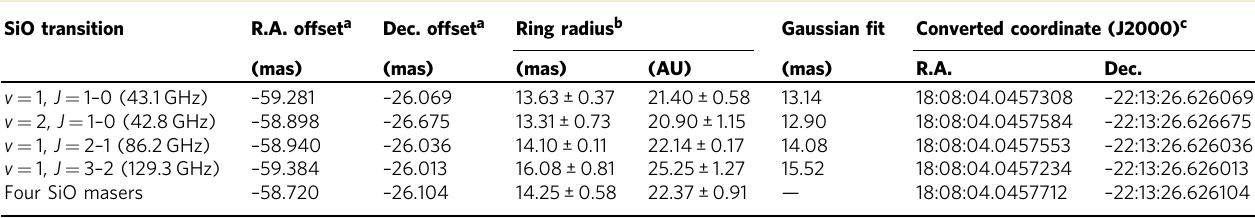
a The offset value represents the position difference of the central star with respect to the observed Hipparcos coordinates (Methods) b The astronomical unit (AU) was calculated using the distance of 1.57kpc for VX Sgr 2 c The coordinates are converted from the observed Hipparcos coordinates based on the R.A and Dec.